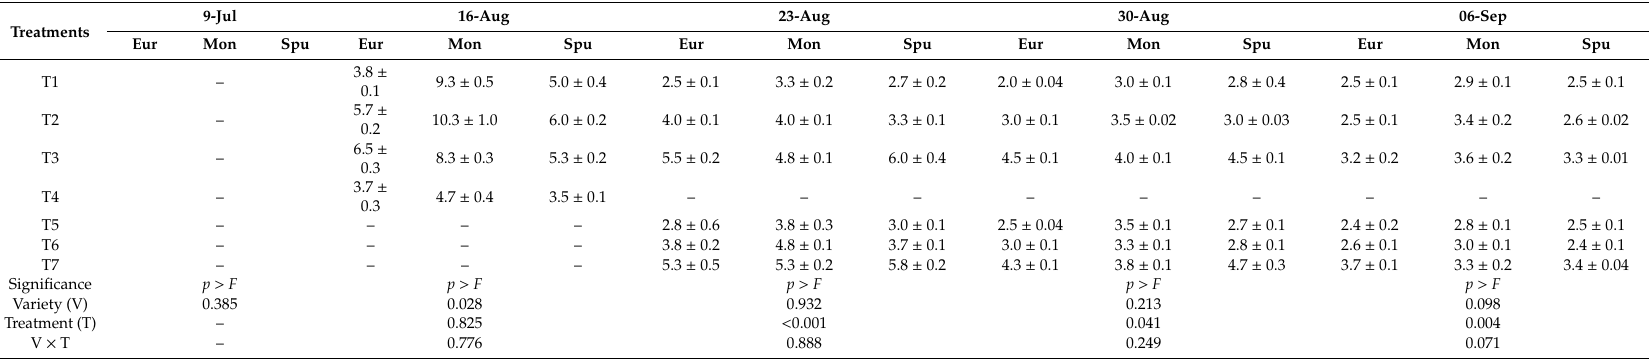
Table 3. Average ( ± standard error) abscisic acid (ABA) content (ng g − 1 fresh weight) of three varieties (Europa, Monalisa and Spunta) subjected to seven dormancy-breaking treatments applied during pre-planting storage condition (Experiment 1). Treatments